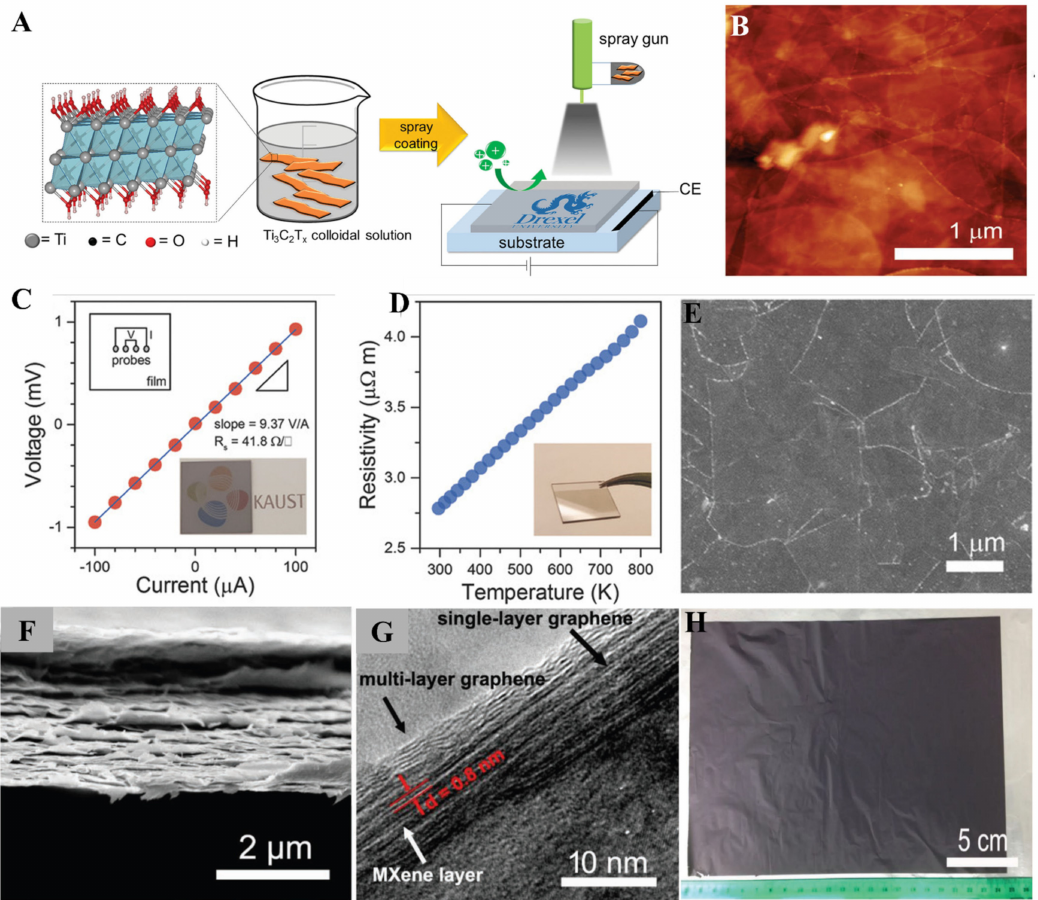
Figure 6. ( A ) Spray coating of Ti 3 C 2 MXene; ( B ) AFM image of the MXene thin film synthesized by using the spray-coating method, (reproduced with permission [88], Copyright 2016 Wiley-VCH); ( C – E ) I-V curves, resistance vs. temperature plot, and SEM image of the Ti 3 C 2 T x thin film fabricated by using the spray-coating method, (reproduced with permission [89]. Copyright 2018 Wiley-VCH); ( F – H ) Cross-sectional SEM image, high-resolution TEM image, and photographic picture of